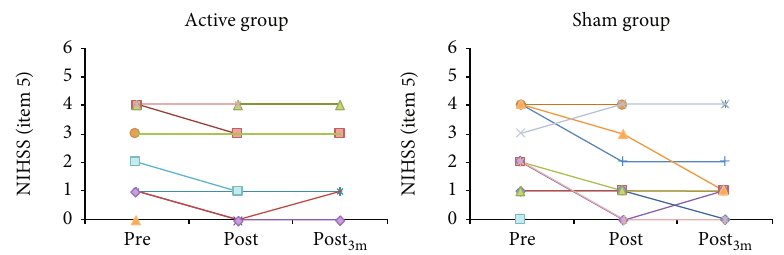
Figure 3: Absolute values of NIHSS (item 5a) scores at speci fi c time points, for each participant in the Active and sham groups. NIHSS: National Institute of Health Stroke